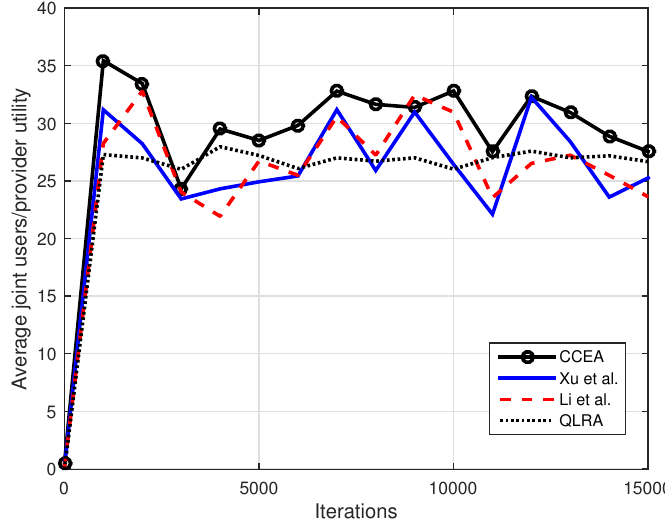
Figure 11. Average joint users’/provider utility